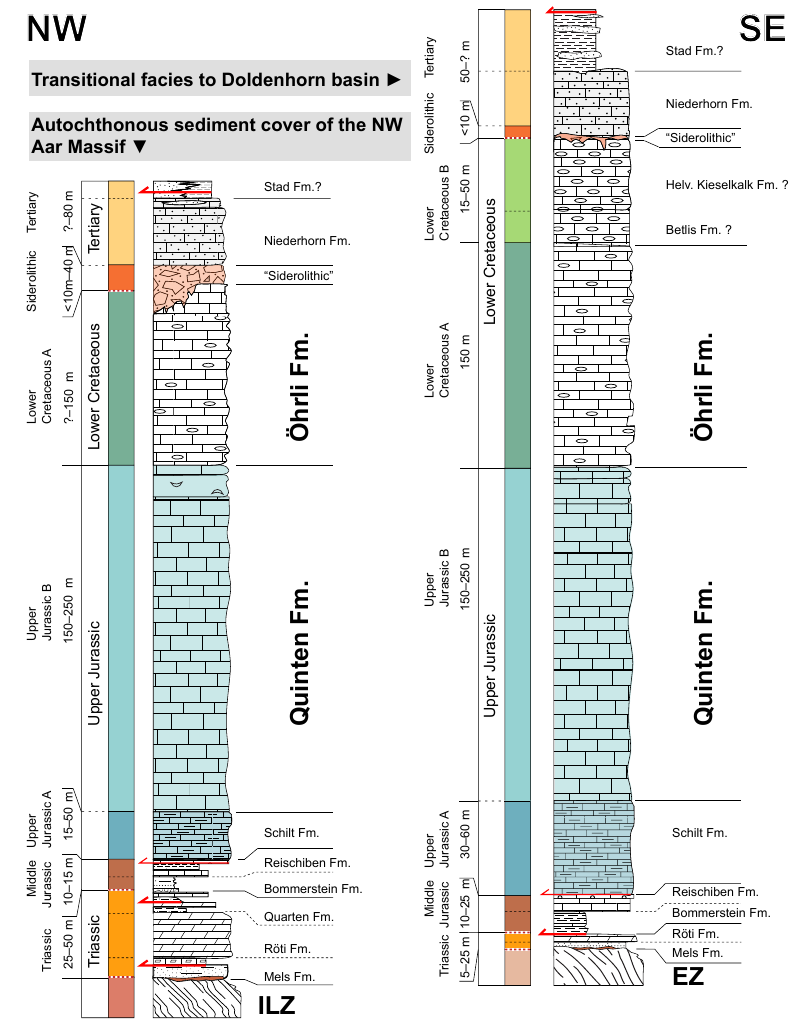
Figure 4. Detailed stratigraphic profiles for the Mesozoic sedimentary cover (for sedimentological discussion, see Appendix A). Future main detachment horizons are marked (red arrows) – ILZ: Innertkirchen–Lauterbrunnen zone, EZ: Erstfeld zone. For references for the thickness estimates and individual unit names, see Table